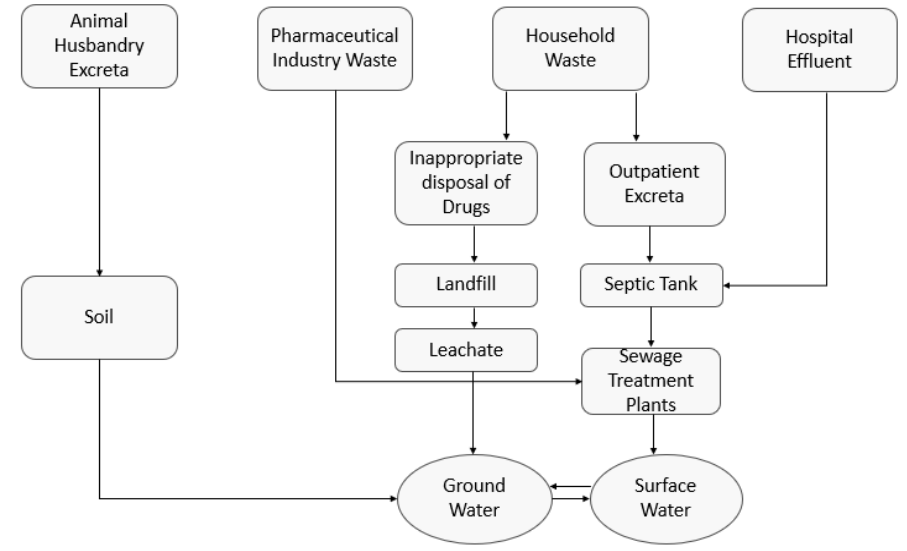
Figure 3. Sources for the introduction of ANP waste into the environment (modified from [51,52]).